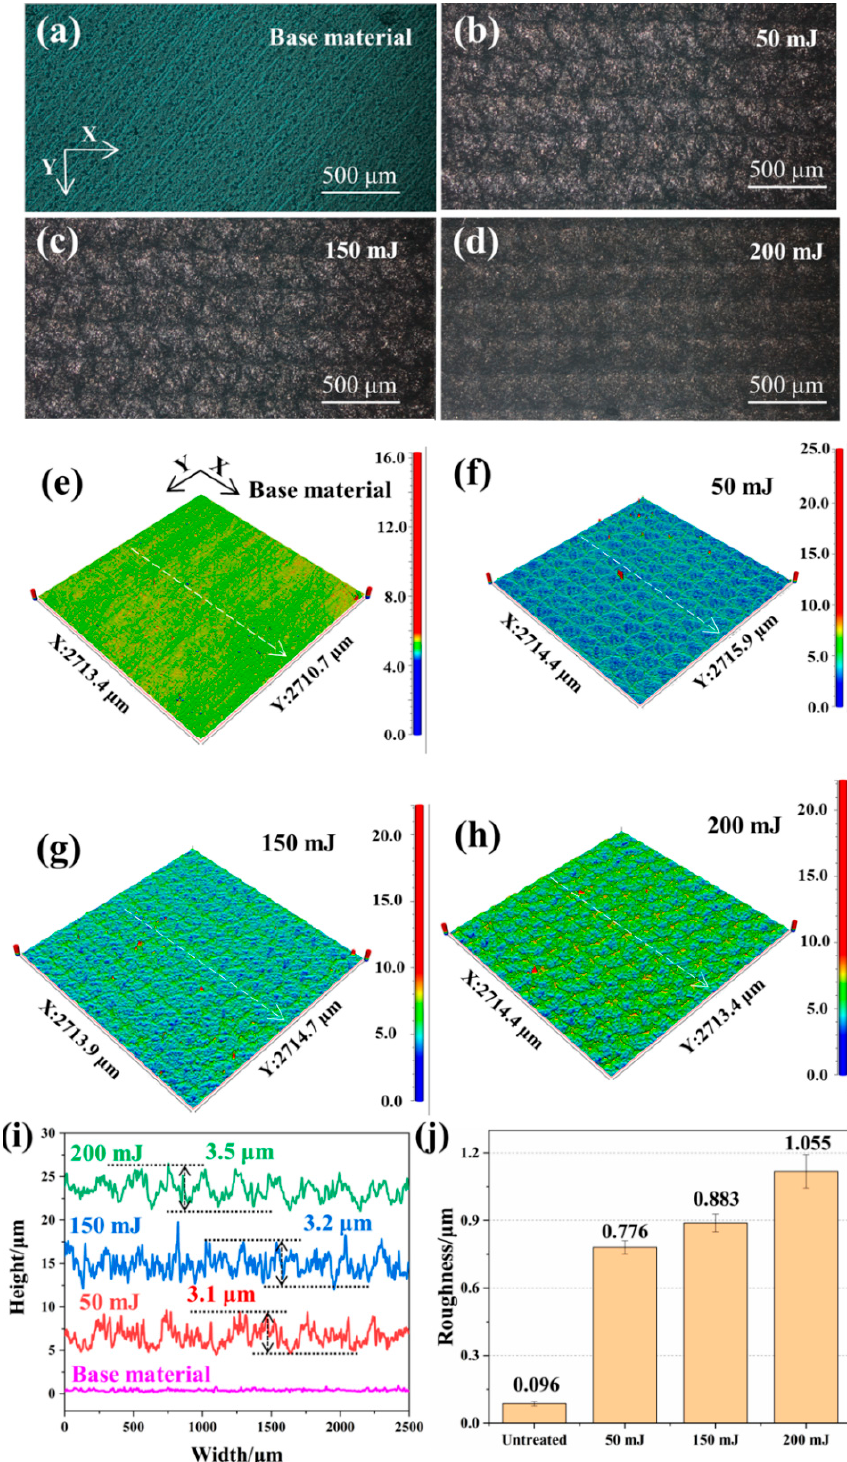
Figure 4. OM morphologies of ( a ) base material; ( b ) 50 mJ; ( c ) 150 mJ; ( d ) 200 mJ. 3D morphologies of ( e ) base material; ( f ) 50 mJ; ( g ) 150 mJ; ( h ) 200 mJ. The ( i ) cross-sectional profiles and ( j ) surface roughness of various Micro-LSP treatments.